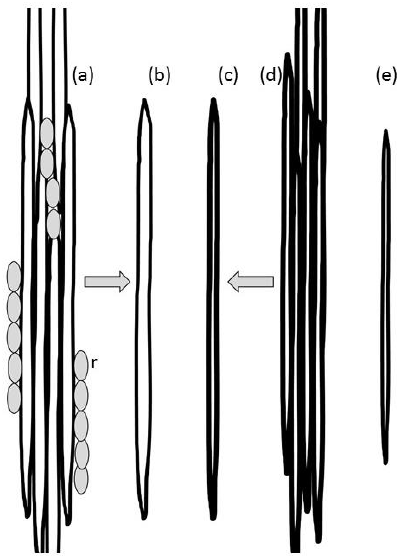
Figure 2. Aspects of various types of fibre. ( a ) Softwood shive, r = ray cell; ( b ) softwood fibre (tracheid); ( c ) bast fibre; ( d ) bast fibre bundle; ( e ) hardwood fibre.